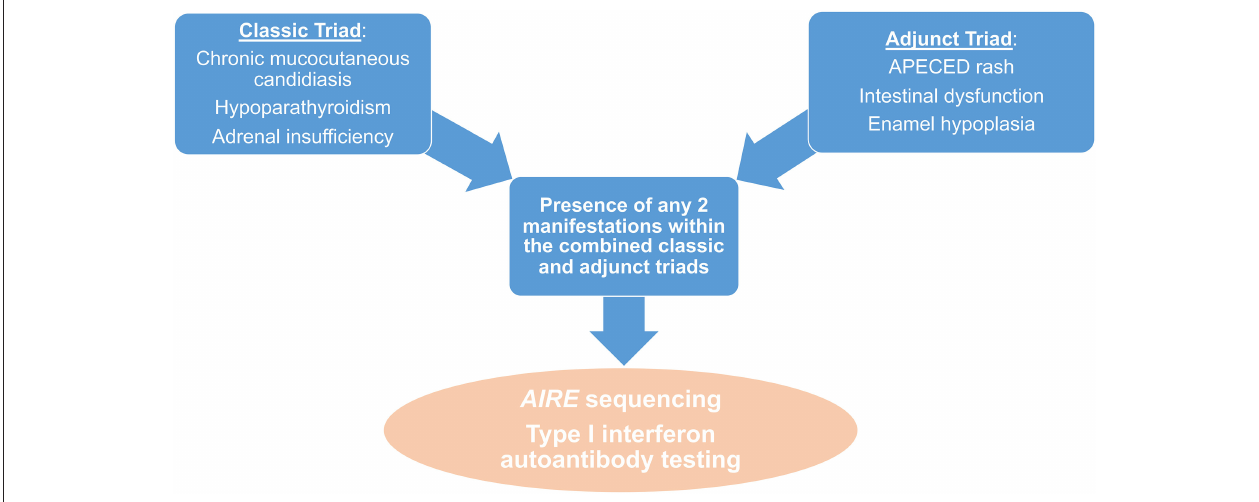
FIGURE 4 | Diagnostic algorithm in patients with suspected APECED. The presence of any 2 manifestations amongst the combined classic and adjunct triads should raise suspicion for APECED and should prompt further work-up with AIRE sequencing and measurement of IFN ω autoantibodies.